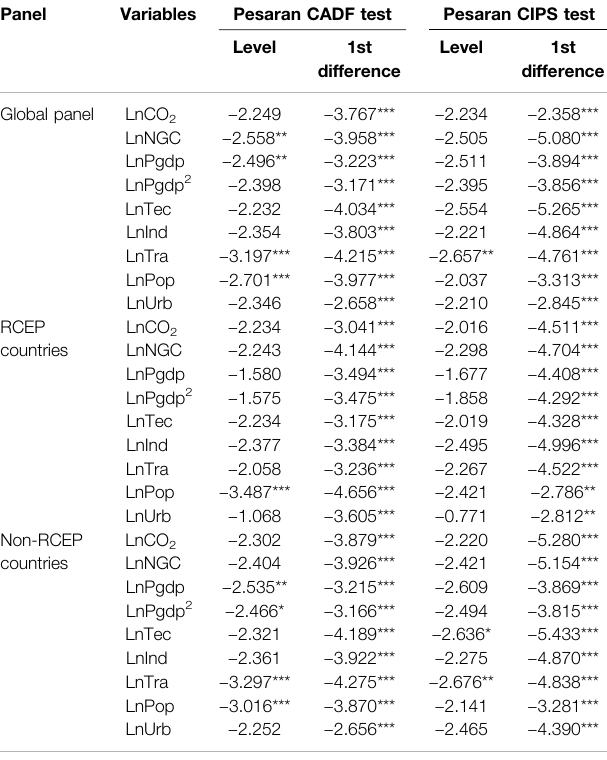
TABLE 4 | Results of the panel CADF and CIPS unit root tests. Pesaran CADF test